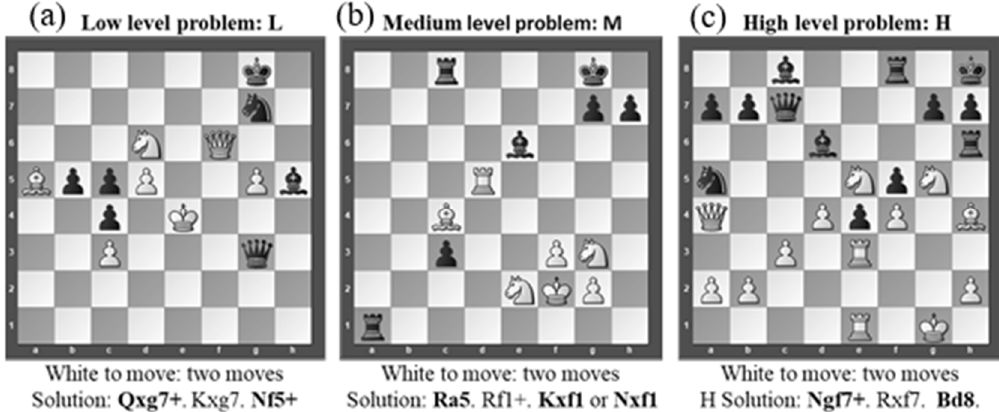
Figure 1. Representation of the three chess-based problem-solving tasks by level of complexity: ( a ) panel—low level problem (L); ( b ) panel—medium level problem (M); ( c ) panel—high level problem (H).